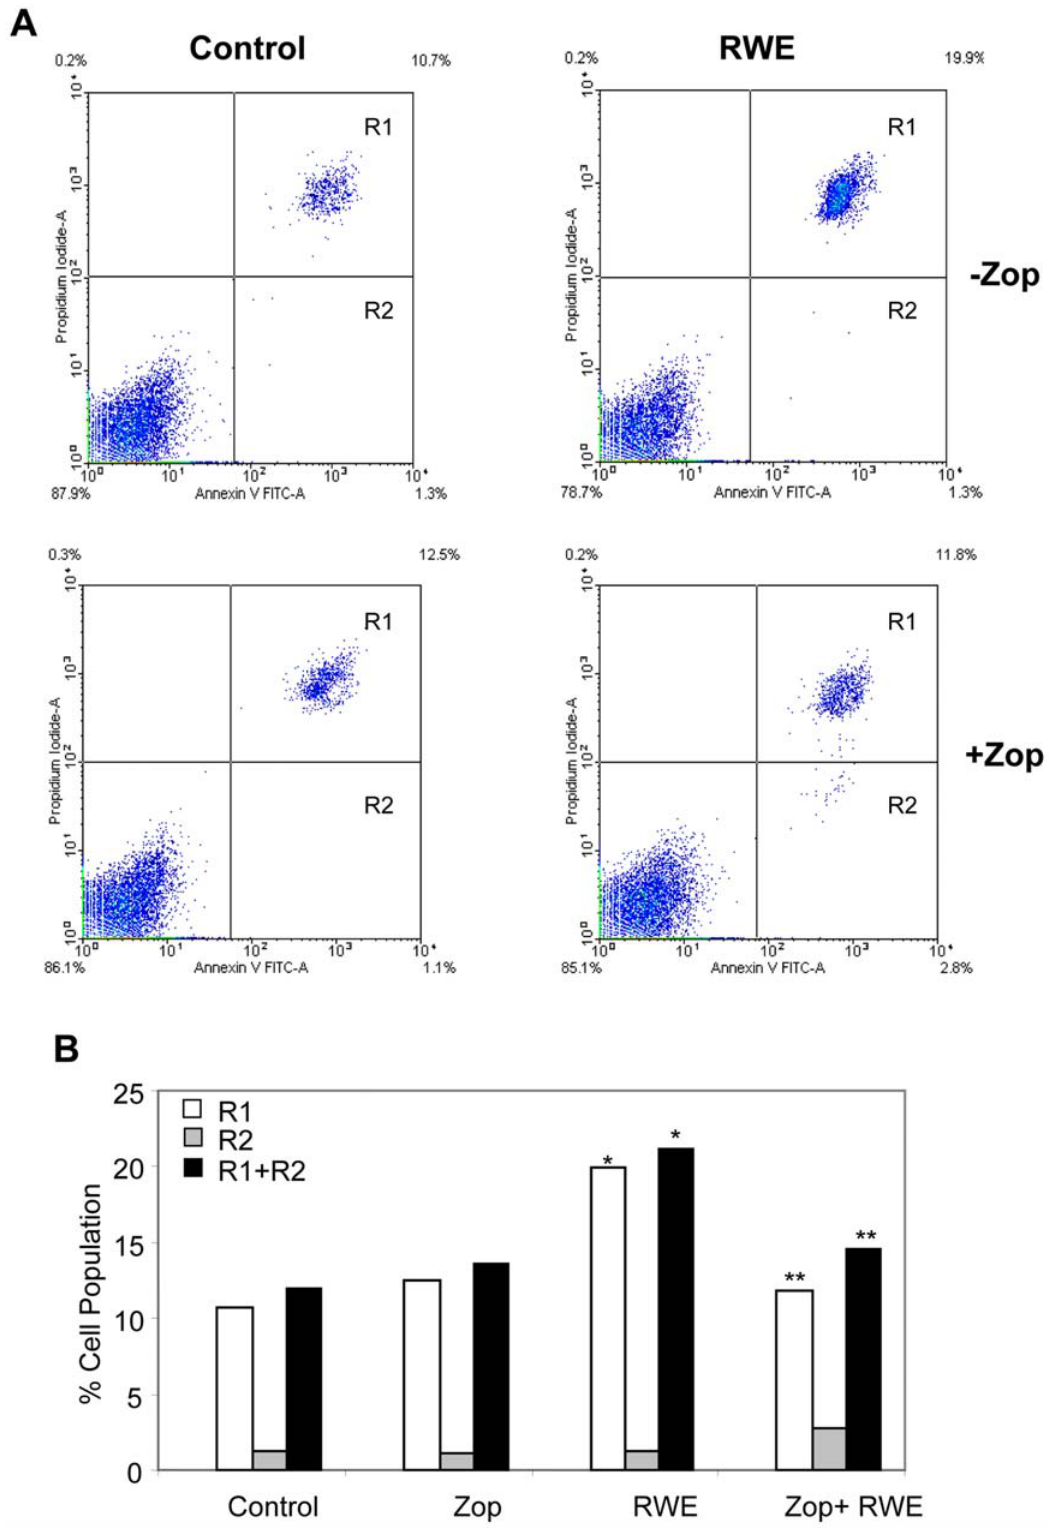
Figure 1. Inhibition of AR prevents RWE-induced apoptosis and cell death in SAEC. (A) Growth-arrested SAEC, pretreated without or with zopolrestat (20 m M), were incubated with 150 m g/ml of RWE for 18 h to induce apoptotic cell death. The cells were stained with annexin-V FITC (FL-1) and propidium iodide (PI) (FL-2). R1 denotes dead cells (PI positive), R2 represents early apoptotic cells (annexin-V positive) and R1 + R2 represents total dead cells. (B) The data from (A) has been plotted as bar diagram (n=4, * p , 0.01 Vs Control; ** p , 0.01 Vs RWE). RWE, ragweed pollen extract; zop, zopolrestat.